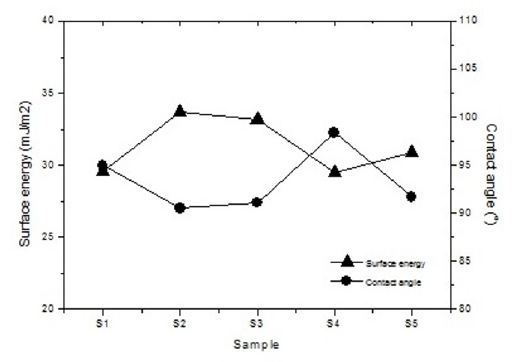
Figure 5. Contact angle and surface energy values of surfaces coated with TiO thin films. 2